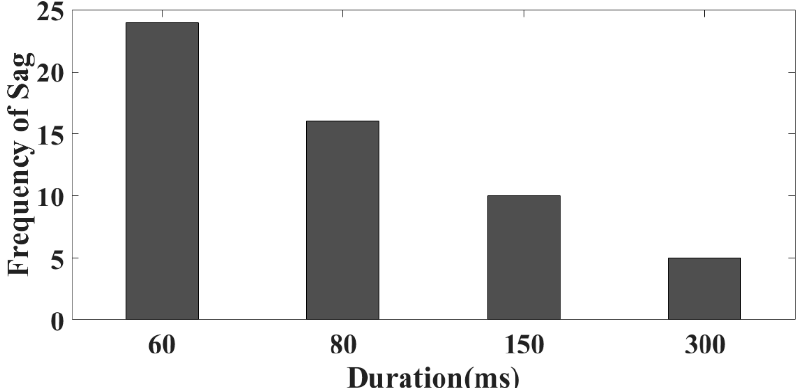
Figure 15. Sags per year for magnitude ranges and duration at bus 15.